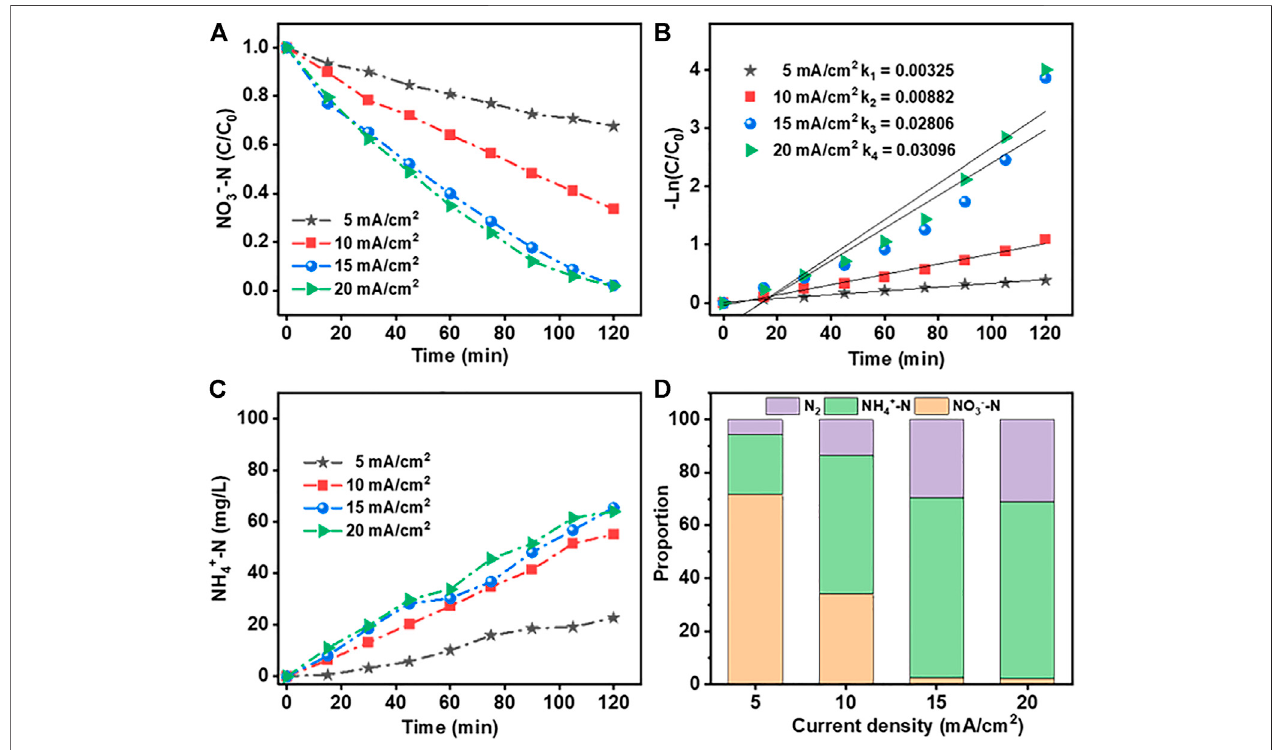
FIGURE 7 | Effects of current density on the NO 3 − -RR using the Co 3 O 4 /Ti cathode (Pt anode; [NO 3 − -N], 100 mg/L, 150 ml; initial pH, 7.0; reaction time, 2 h): (A) and (B) rate of loss of NO 3 − -N and the fi t of the data to fi rst-order kinetics; (C) rate of generation of NH 4+ -N; and (D) distribution of the products formed.